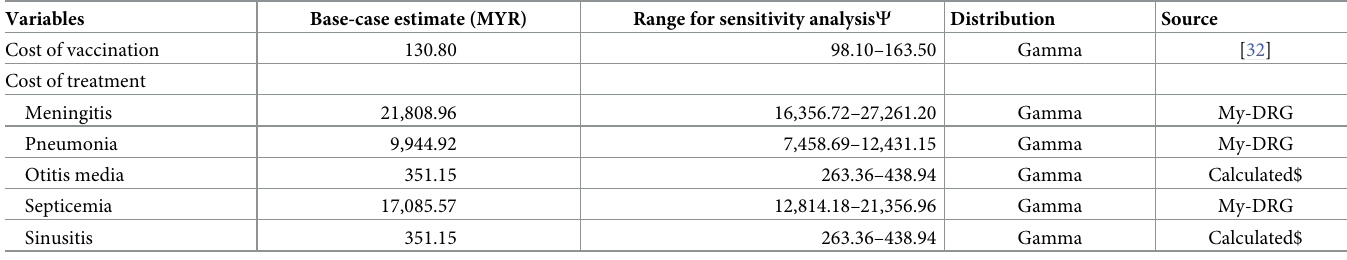
Table 4. The costs of vaccine per dose and pneumococcal disease.